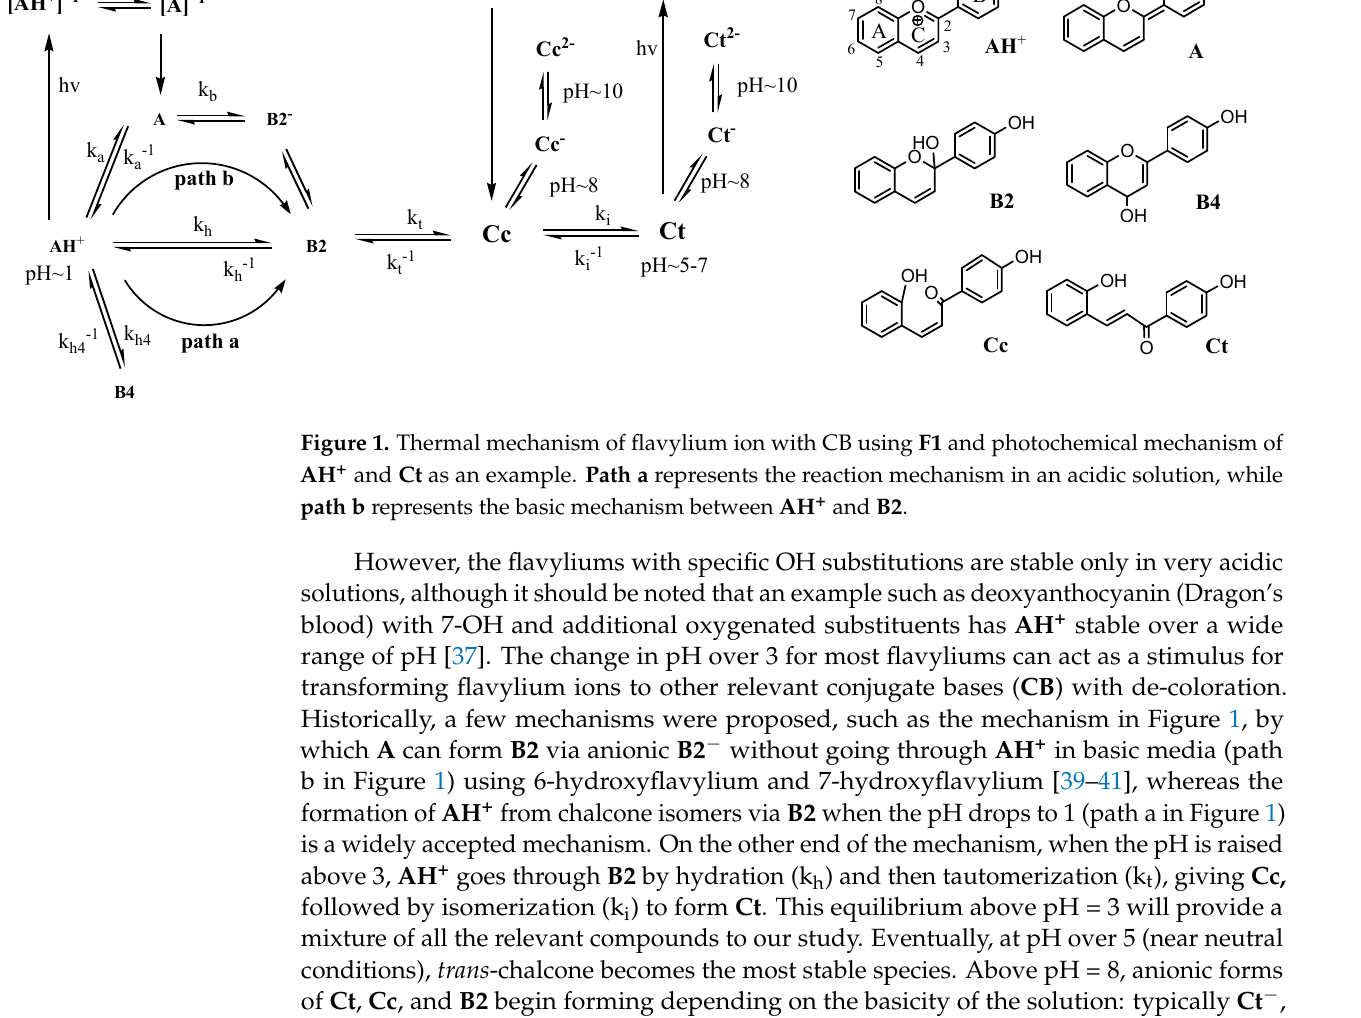
( CB : shown in Figure 1 as A , B2 , Cc , Ct , and their anionic species) are well documented by Brouillard [14], McClelland/Gedge [15], Pina, and others [13]. The flavylium cation ring ( AH + ) in natural anthocyanins has different hydroxy and alkoxy groups commonly on 3, 5, 7, 3’, 4’, and 5’, demonstrating multiple functions in nature [16–23]. The pH-responding structural change gives a broad range of applications stemming from the different chro- mic and optical properties due to pH-adjusted structures. The optical property within the visible range of the colored flavylium ion ring for light-harvesting applications such as